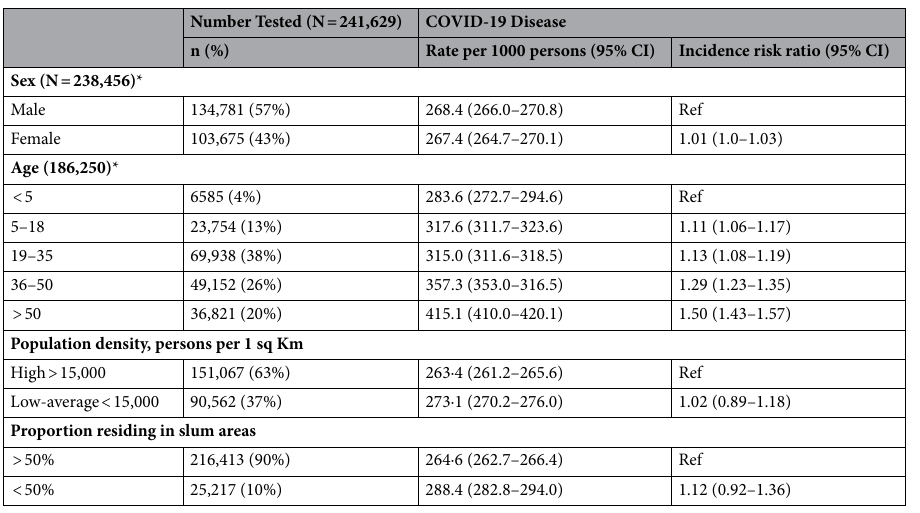
Table 1. Estimated rate and incidence risk ratio of COVID-19 disease during the study period by population characteristics in Pune Municipal Corporation, India. *Available